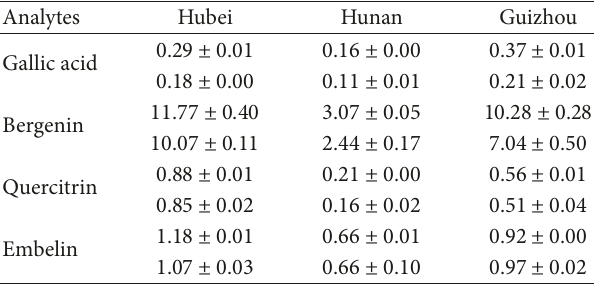
Table 4: The concentrations (mg g −1 ) of four analytes in the